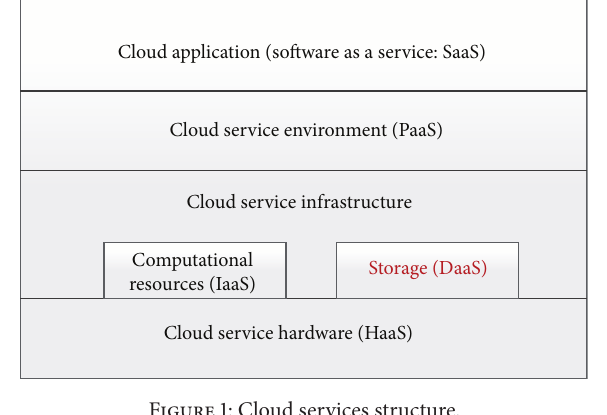
Figure 1: Cloud services structure.